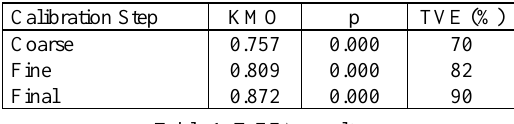
Table 1. T-EFA results